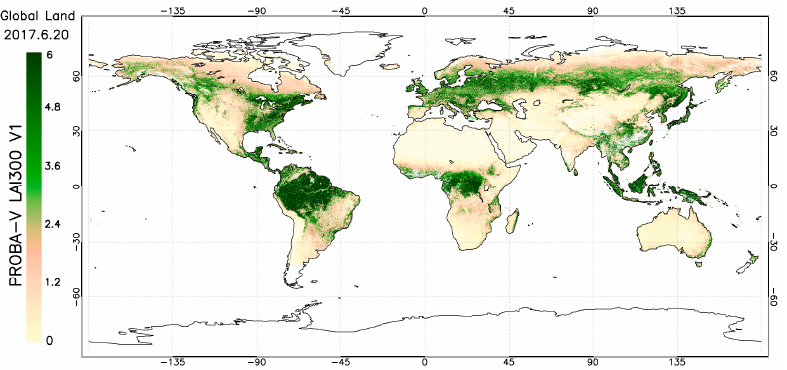
Figure 1. Global distribution of leaf area index (LAI) values from CGLS PROBA-V Collection 300 m V1 for 20th June 2017.